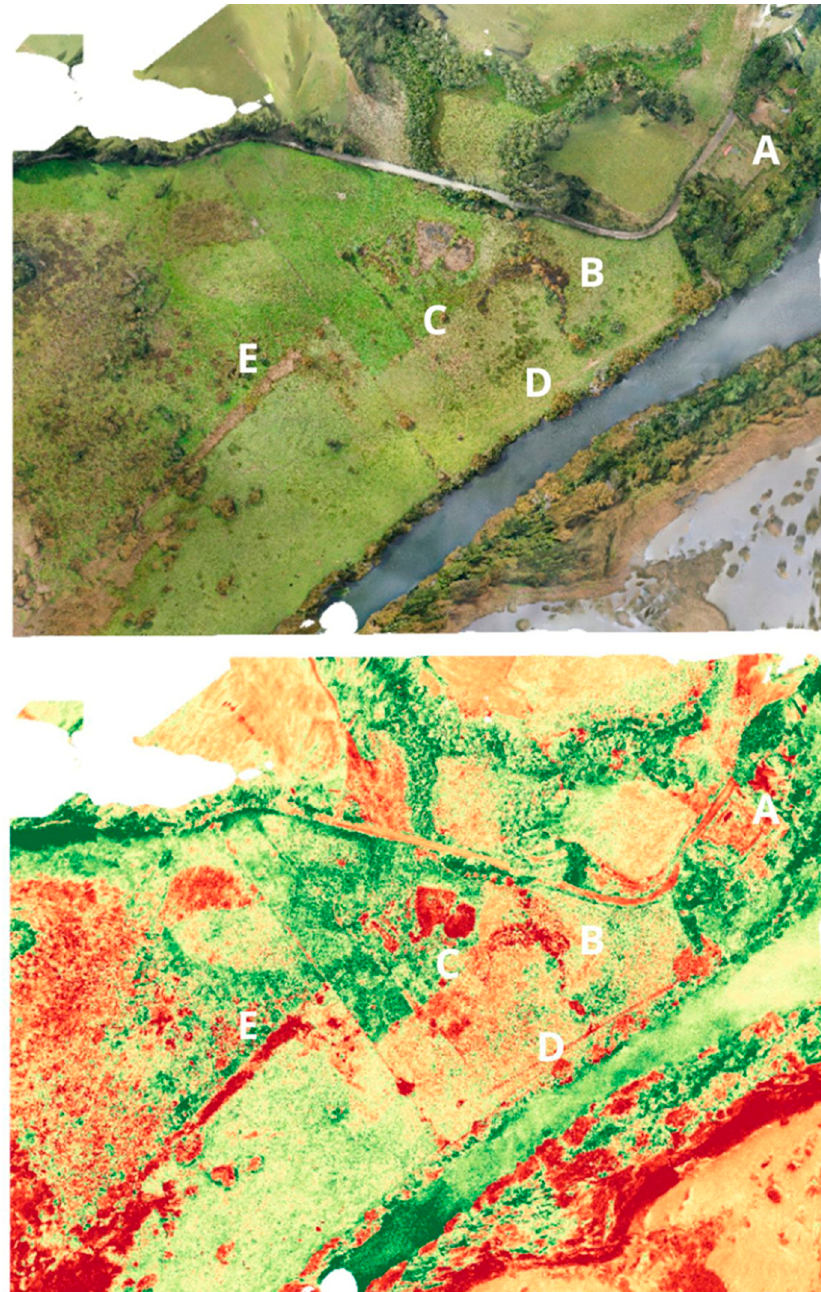
Figure 4. Photograph obtained during fieldwork in the San Luis del Alba area, March 2022. ( A ) San Luis del Alba Fort. ( B , C ) Possible remains of Cruces Village. ( D ) Path. ( E ) Drainage